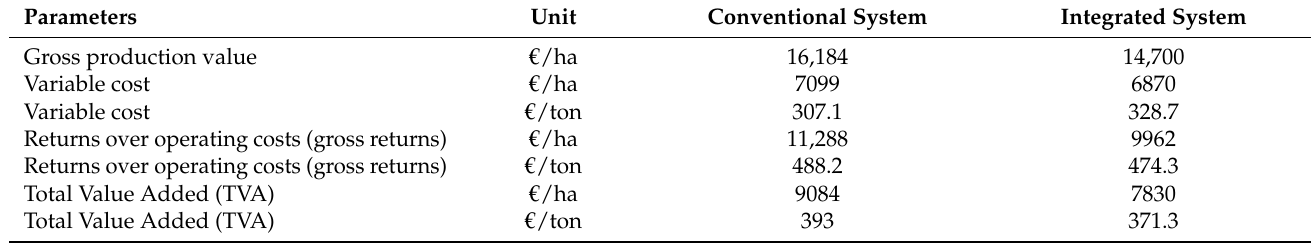
Table 4. Economic indicators of table grape farming with conventional (groundwater) and integrated (groundwater + reclaimed water) irrigation.